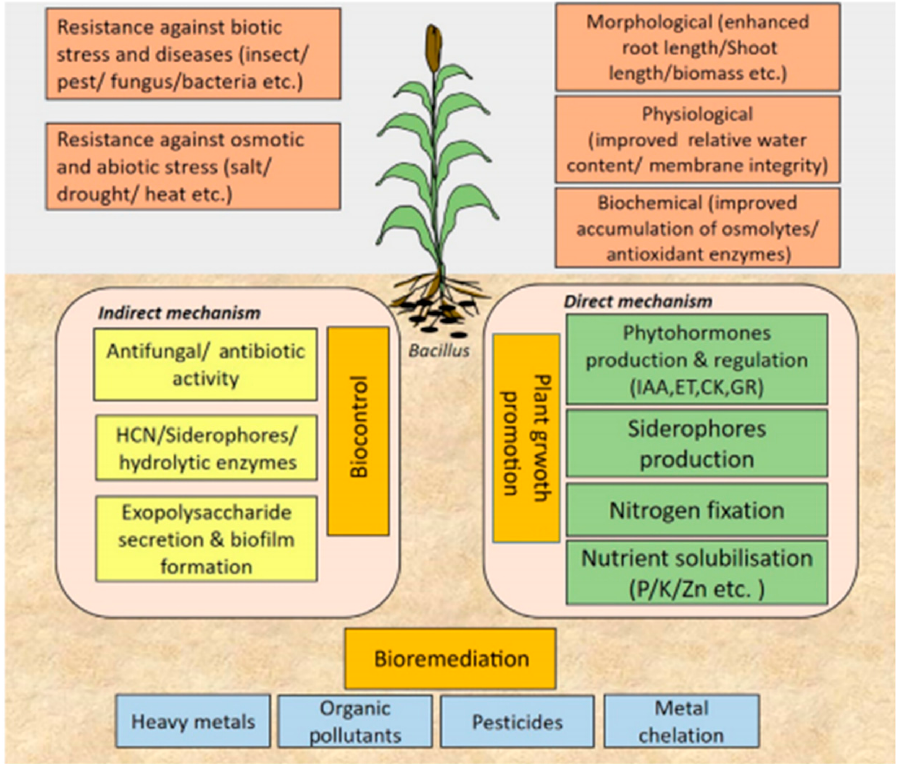
Figure 7. Root colonization process of endophytic bacteria of the genus Bacillus sp. [97].